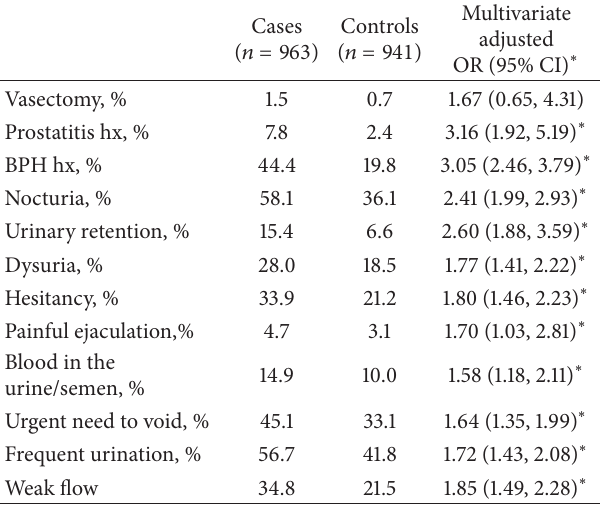
Table 1: Urologic characteristics among PCBP African-Barbadian